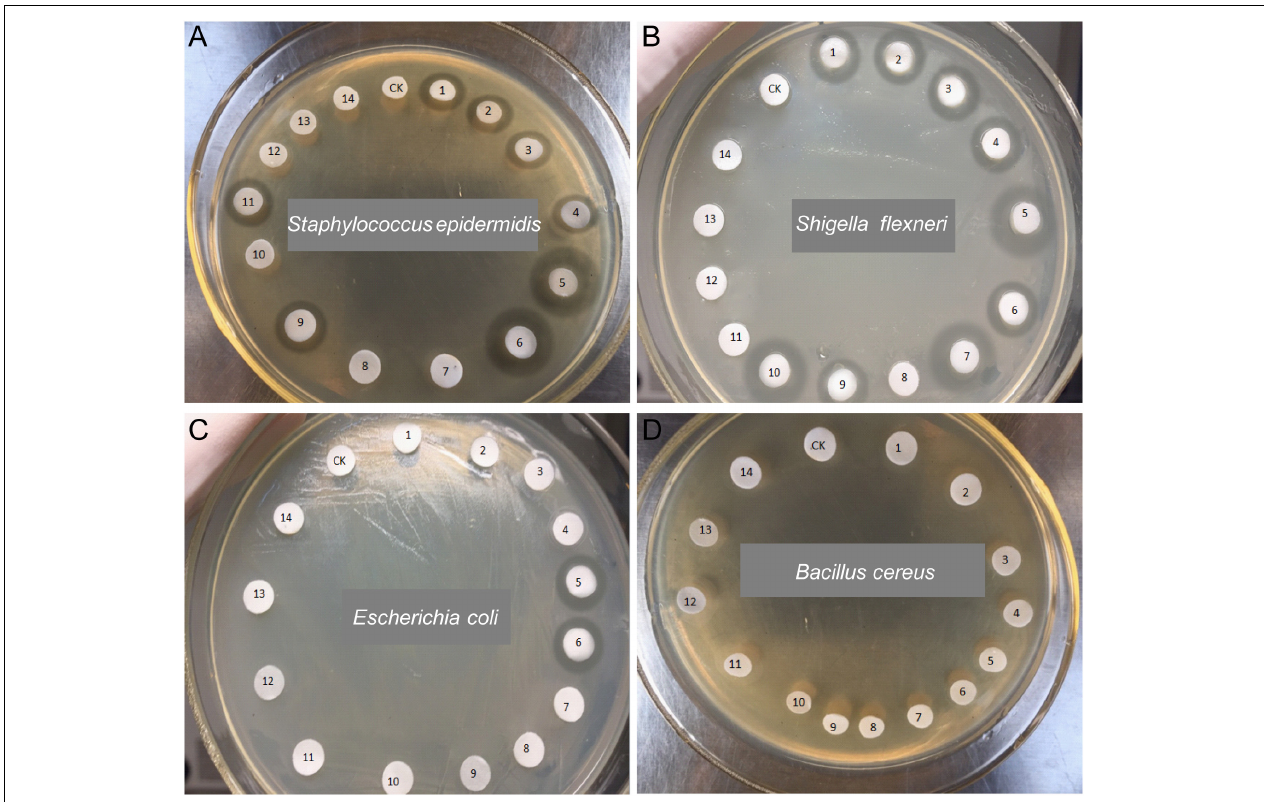
FIGURE 2 | Antimicrobial activities of endophytic actinobacteria against pathogenic bacteria. Staphylococcus epidermidis (A) , Shigella flexneri (B) , Escherichia coli (C) , and Bacillus cereus (D) were the tested strains. CK-Vehicle, 1-YFT113, 2-YXN120, 3-YXN111, 4-YXN112, 5-YXT131, 6-YKFG1221, 7-YKFG1121, 8-YKFG1122, 9-YKFT1130, 10-YKFH1122, 11-YKFG1112, 12-ZFY142, 13-ZFG130, 14-ZJFT1121.